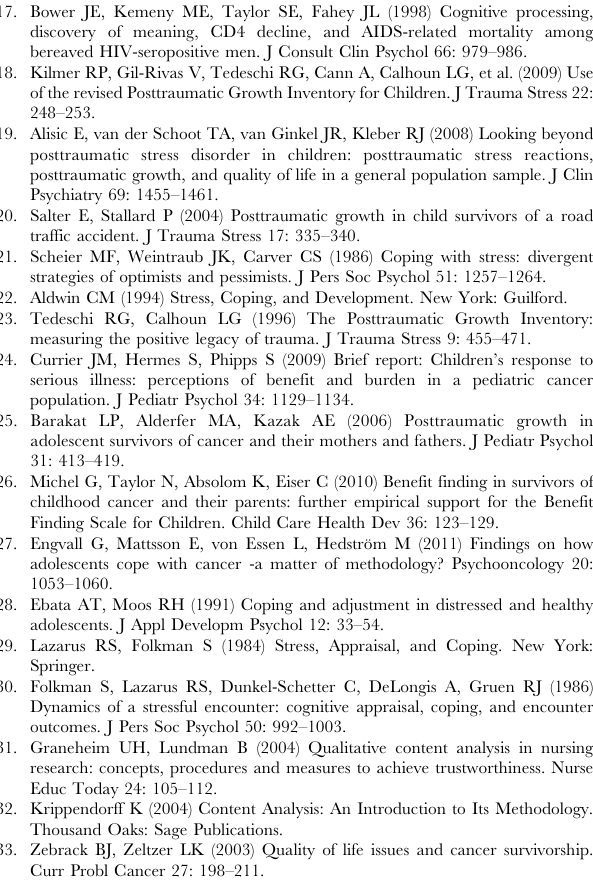
Table S3 A presentation of the number of participants a reporting using and not using a certain coping strategy shortly after diagnosis (T1) and reporting and not reporting a certain consequences four years after diagnosis (T7) (N=